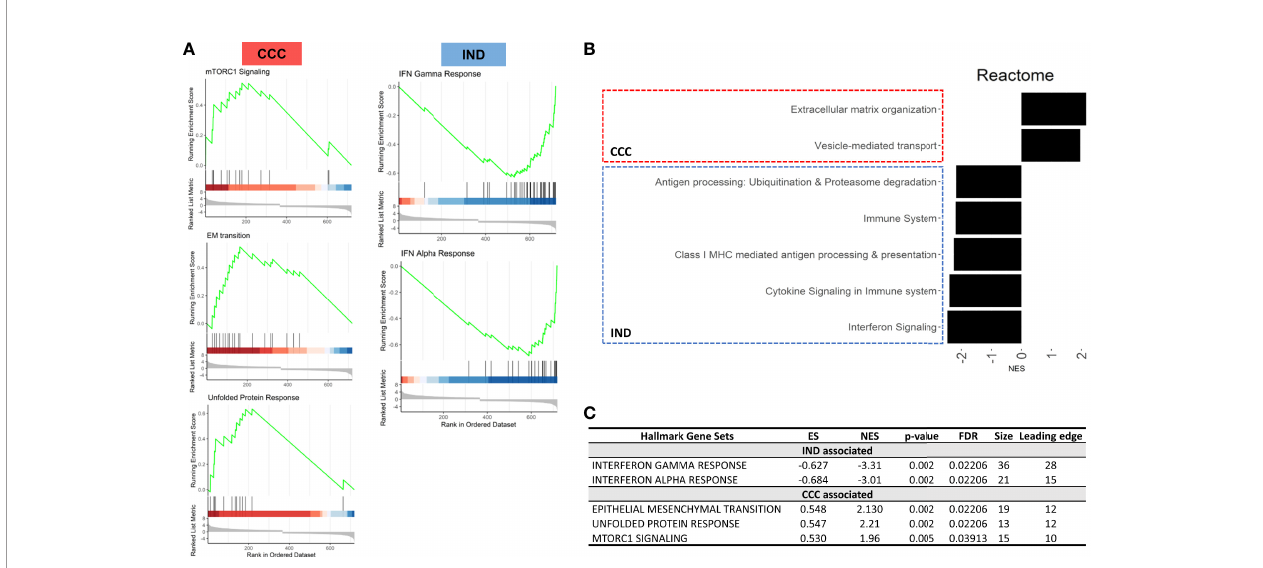
FIGURE 4 | Results from GSEA with Hallmark terms. (A) GSEA plots showing the rank distribution of DEGs in Hallmark gene sets and the association with each phenotype (red bars – CCC; blue bars – IND). (B) Reactome plot with the NES for the pathways associated to each group. (C) Hallmark gene sets associated with each phenotype. ES, Enrichment Score; NES, Normalized enrichment score; FDR, False-discovery